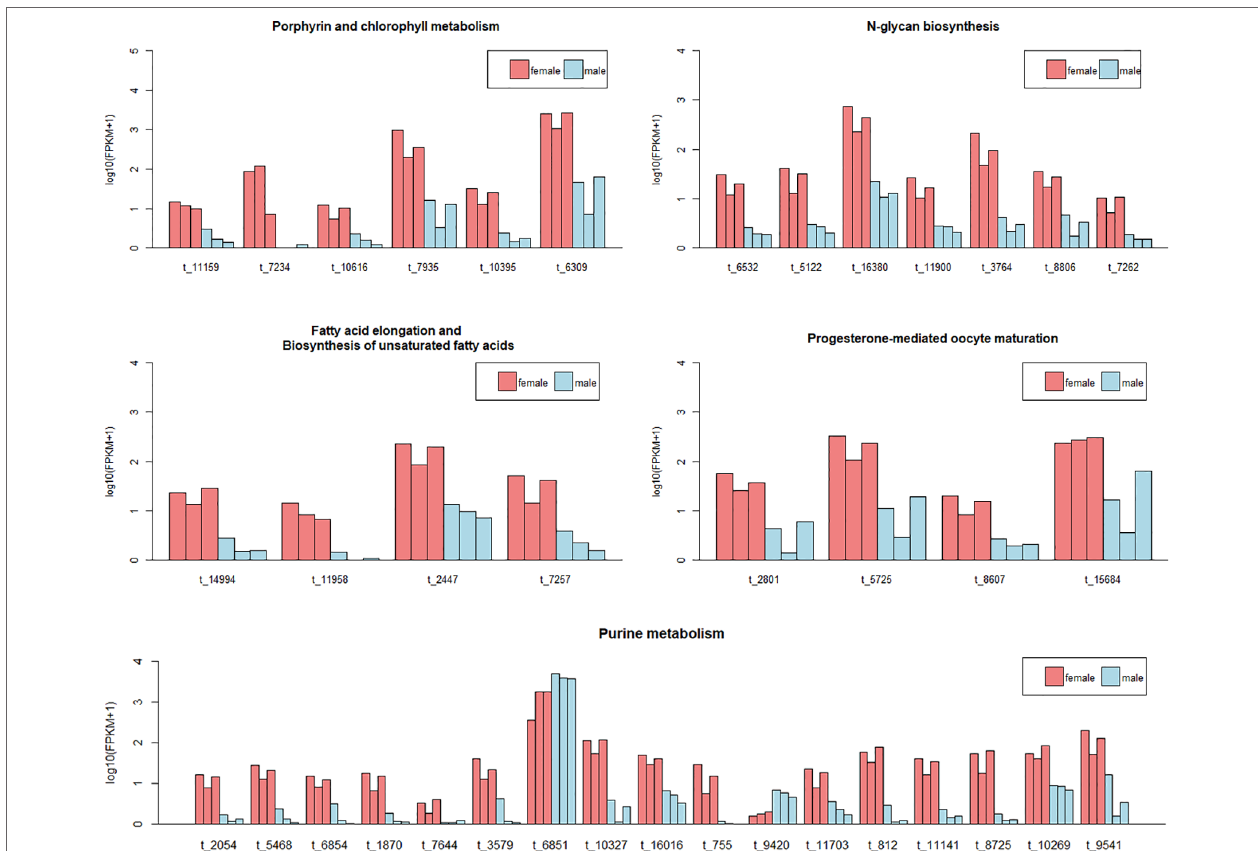
FIGURE 4 | The expression level of the differentially expressed transcripts (DETs) of muscle in five pathways. Each bar represents one sample. Different colors indicate different sexes. The abscissa represents the transcript ID. The ordinate represents the logarithm of the (FPKM+1). Since the DETs in pathways of fatty acid elongation and biosynthesis of unsaturated fatty acids were same, we combined the two pathways in one plot.